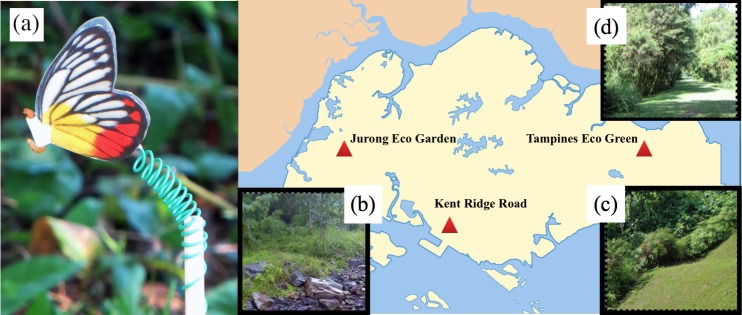
Photo of model in the field and localities of where field experiments were conducted.(a) Artificial butterfly model attached to live mealworm and a wooden rod via a coiled green metal wire. (b-d) The vegetation/general terrain found at each field site: (b) Jurong Eco Garden (Trial 3), (c) Kent Ridge Road (Trial 1), and (d) Tampines Eco-Green (Trial 2).